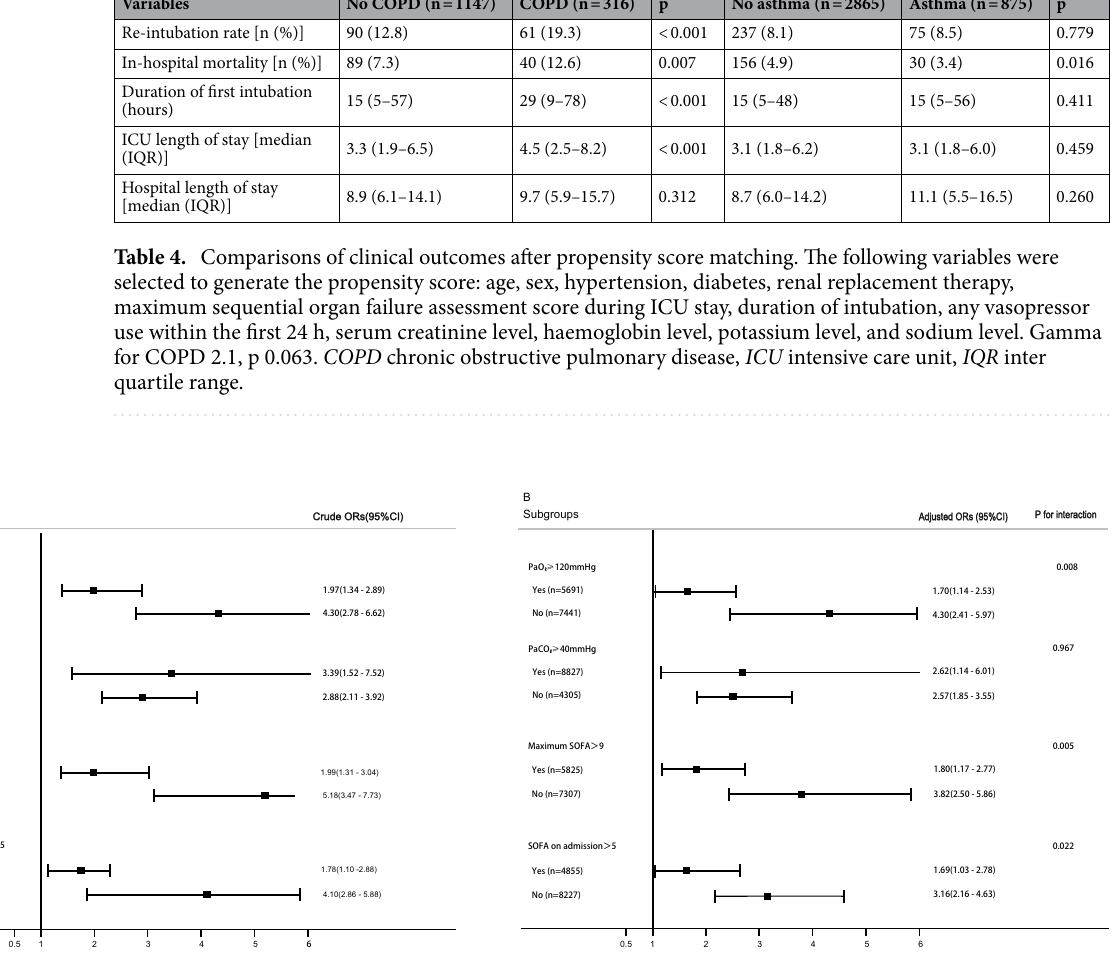
Figure 1. Factors influencing the impact of COPD on re-intubation rate. The impact of COPD on re-intubation rate was found to be affected by post-extubation PaO 2 and SOFA but not by PaCO 2 . SOFA sequential organ failure assessment, COPD chronic obstructive pulmonary disease, PaCO 2 carbon dioxide partial